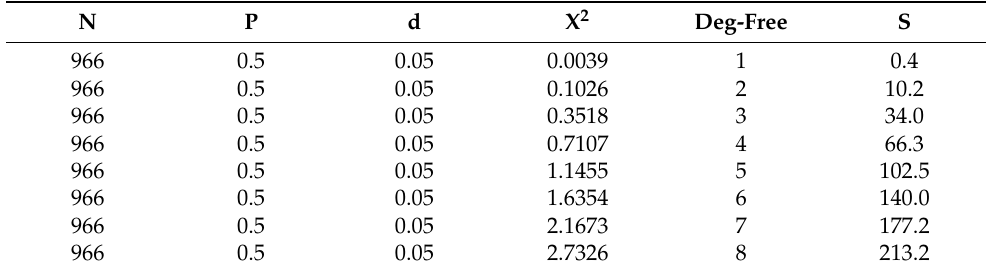
Table 2. Quick estimation of a minimum sample size for a population of 966 [30].